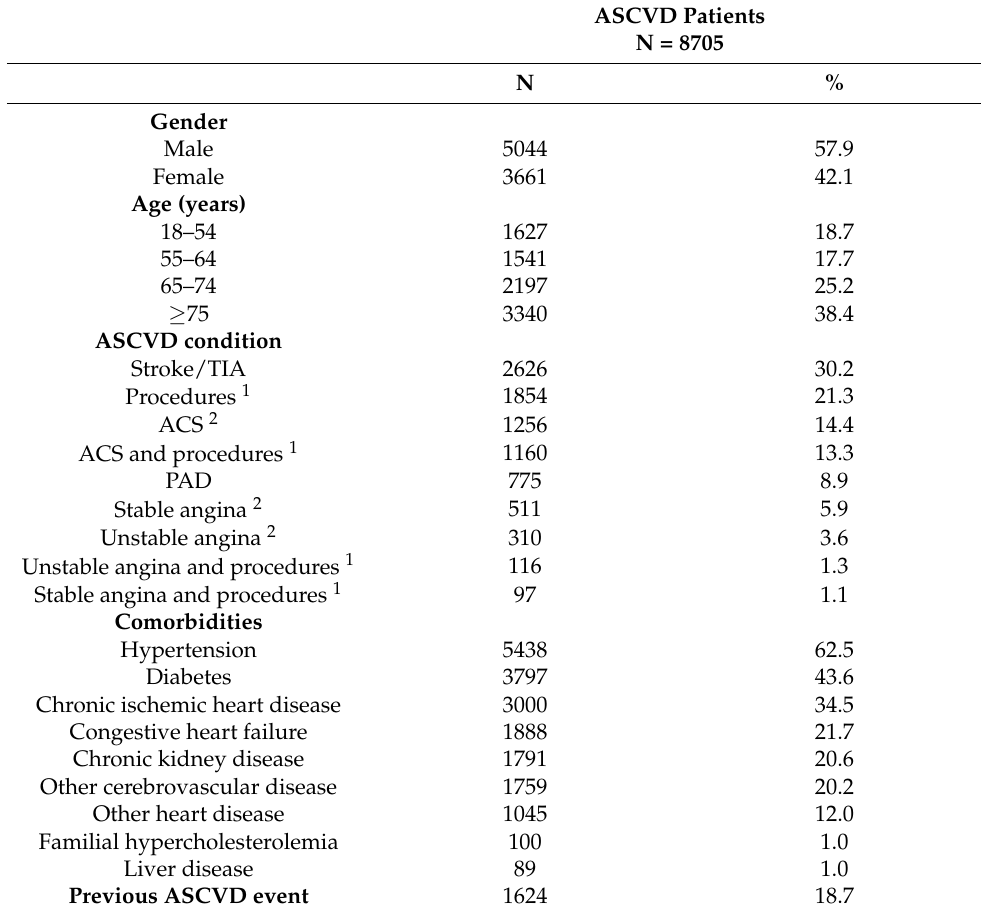
Table 1. Demographic and clinical characteristics for the study